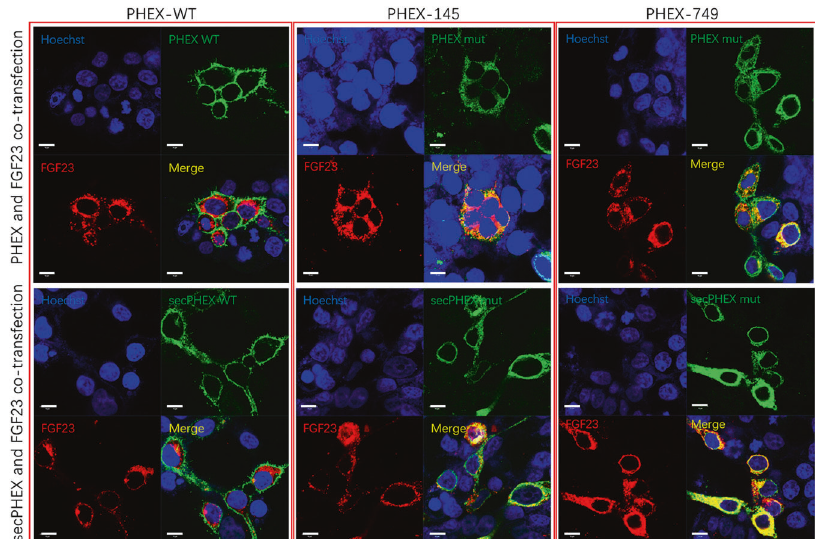
Fig. 3 The localization of wild-type and mutant PHEX, secPHEX, and FGF23, as detected using immuno fl uorescence in HEK293T cells co- transfected with PHEX , sec PHEX , and FGF23 . Wild-type PHEX, secPHEX, and FGF23 proteins are distributed in the cell membrane or endoplasmic reticulum, while the mutant is located in the nuclear membrane (possibly endoplasmic reticulum) and cytoplasm. In order to clearly show the positional correlation between co-transfected FGF23 and PHEX expressed in cells, the fi gures were overexposed. WT wild type, mut mutation type, sec secretory type. Scale bar, 10 μ